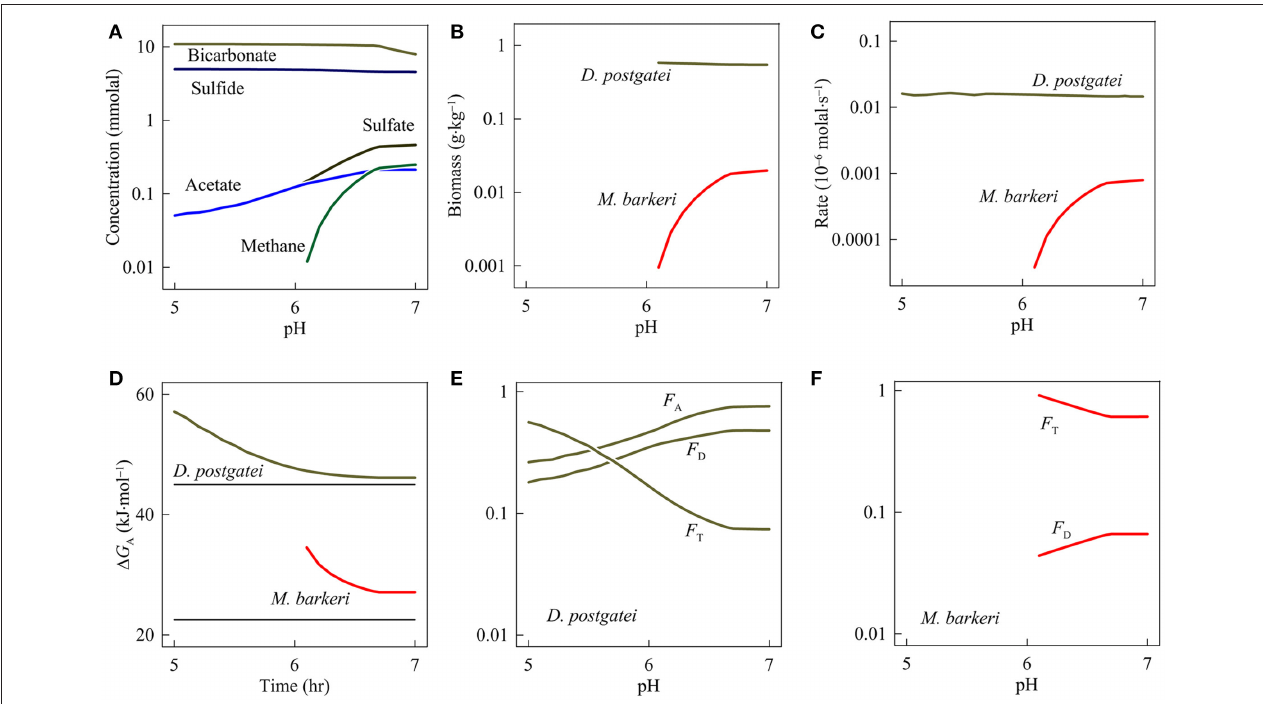
FIGURE 4 | Variation with pH in the concentrations of bicarbonate, sulfide, sulfate, acetate, and methane (A) , and the biomass concentrations (B) , the respiration rates (C) , the available energies 1 G A (D) , the thermodynamic potential factors F T , and the kinetic factors F D and F A of Desulfobacter postgatei (E) and Methanosarcina barkeri (F)